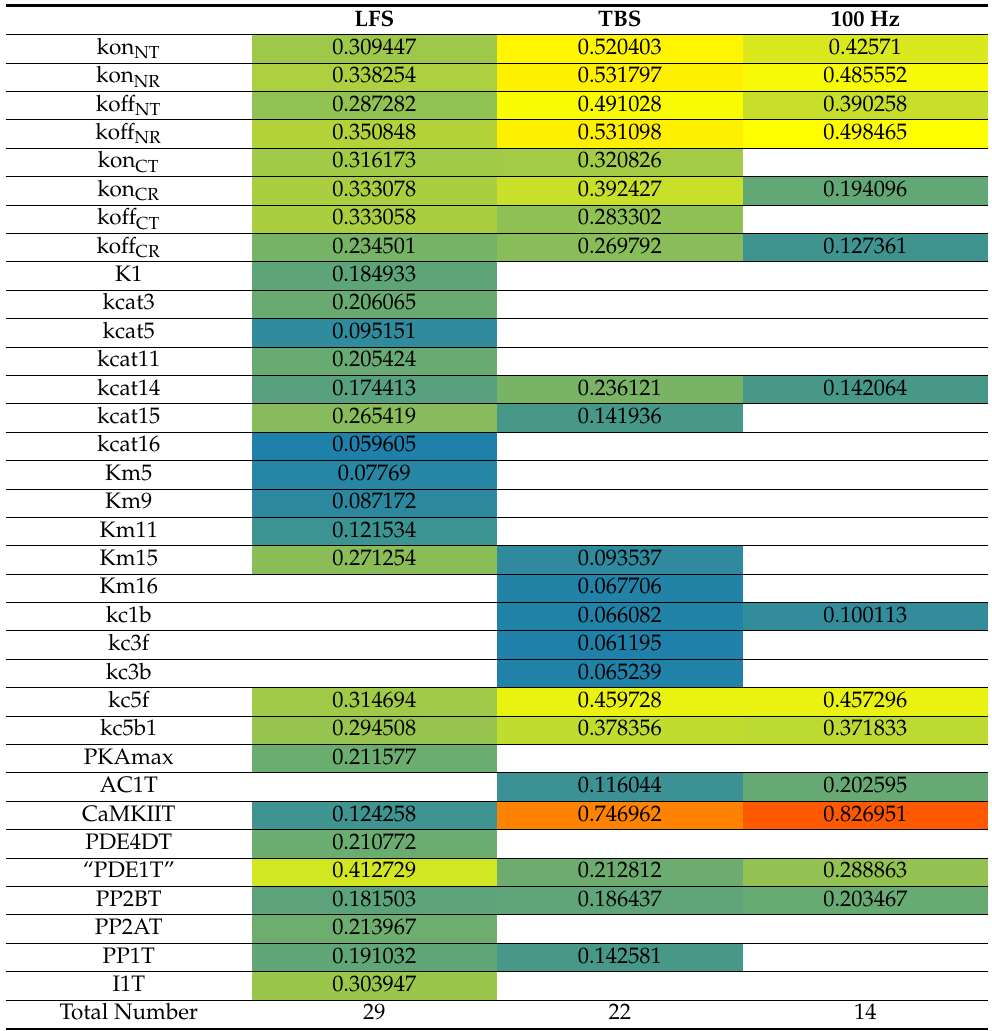
Table 4. GSA of CaM4. Each row represents a model parameter and its PRCC at each of the three stimulations. Empty cells represent no significant PRCC value ( p < 0.0001). The color indicates the significance of PRCC values: Blue is low significance; Green is moderate significance; Yellow is high significance; and Red means very strong